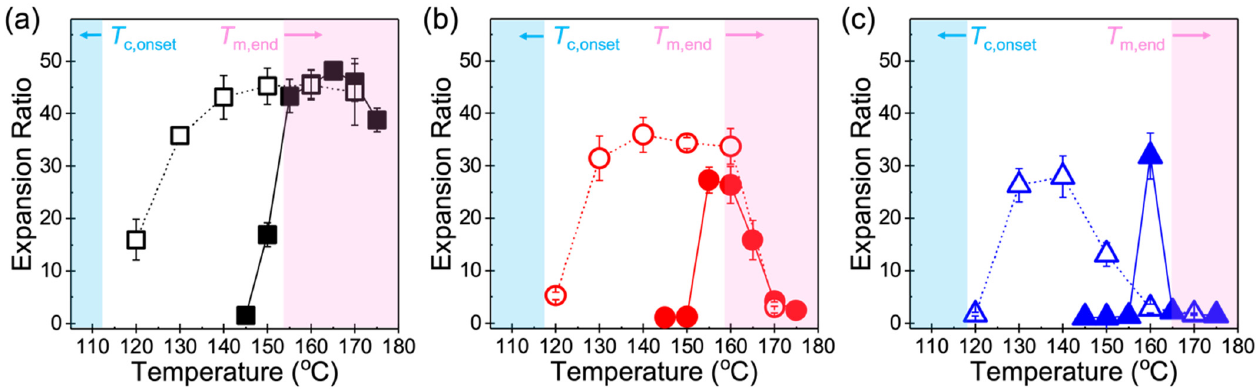
Figure 5. Volume expansion of ( a ) Resin A, ( b ) Resin B, and ( c ) Resin C with respect to foaming temperature. Closed and open symbols (with lines as a guide to the eye) refer to expansion ratios obtained using Method 1 and Method 2, respectively. Shaded areas indicate low and high temperature regions determined by the respective T c,onset and T m,end values obtained from HP-DSC measurements in Figure 4.